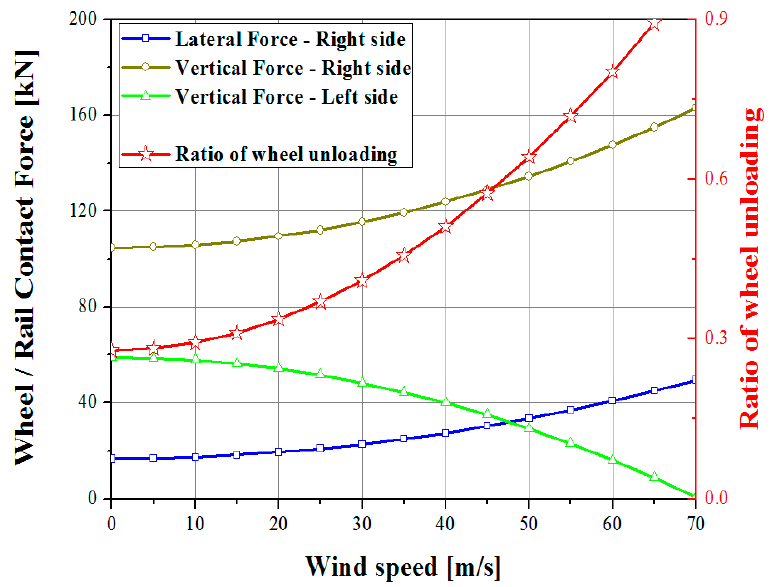
Figure 10. The ratios of wheel unloading to cross-wind speeds under the overturning derailment condition.